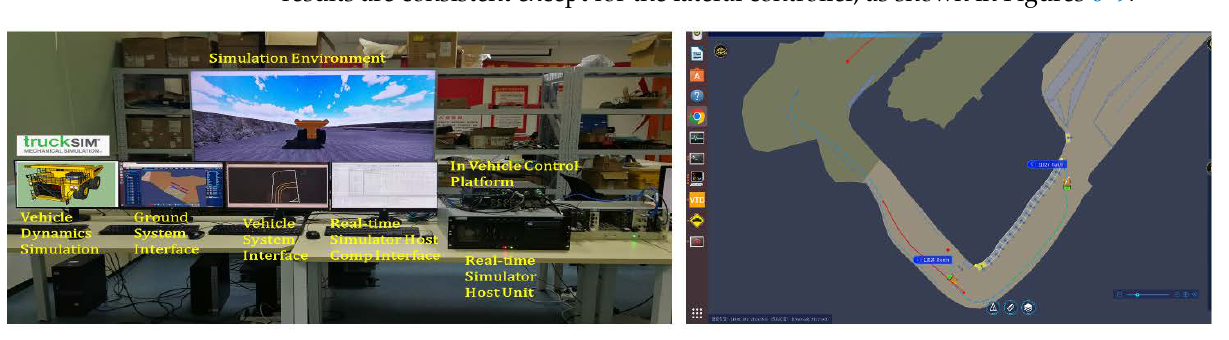
Figure 5. Hardware-in-the-loop simulation platform ( left ). Virtual simulation map ( right ).